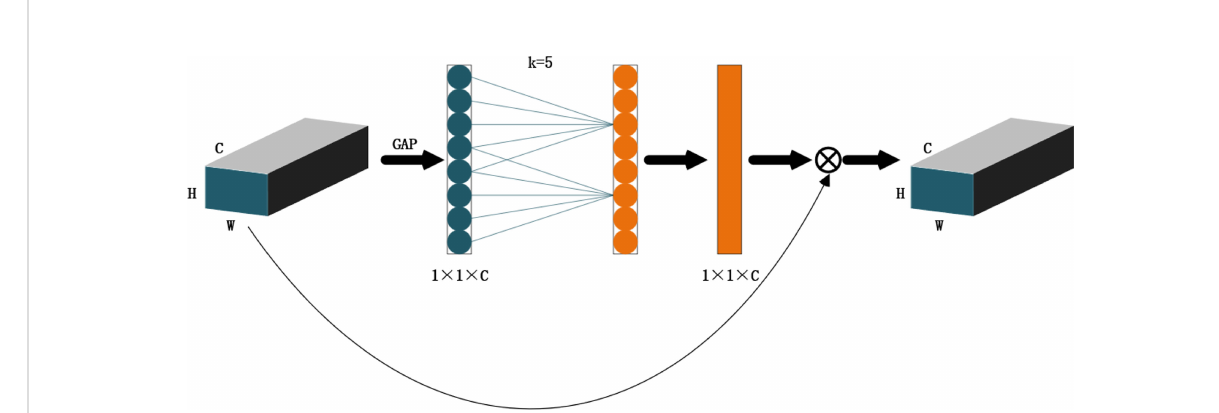
FIGURE 7 The ECA module structure diagram. Note: C is the number of channels, H is the height of the input data, W is the width of the input data, and K is the convolution local interaction size. The global average pooling of gap, s , activates the function for